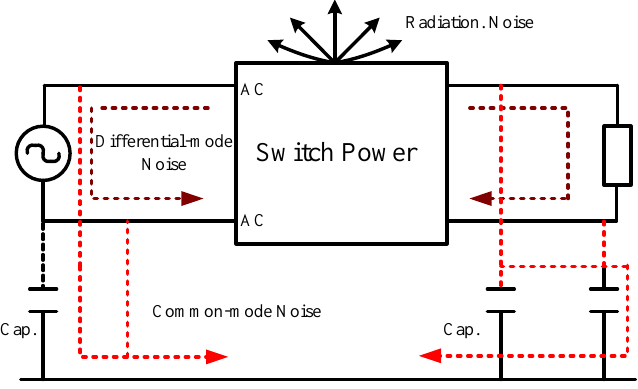
Figure 1. Electromagnetic interference (EMI) induced by a power converter.